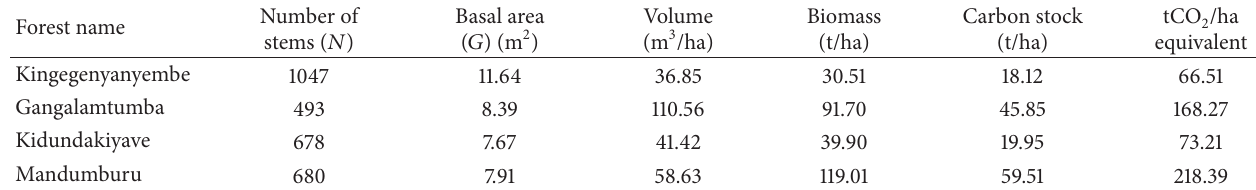
Table 3: Miombo woodland parameters describing biomass as studied in different